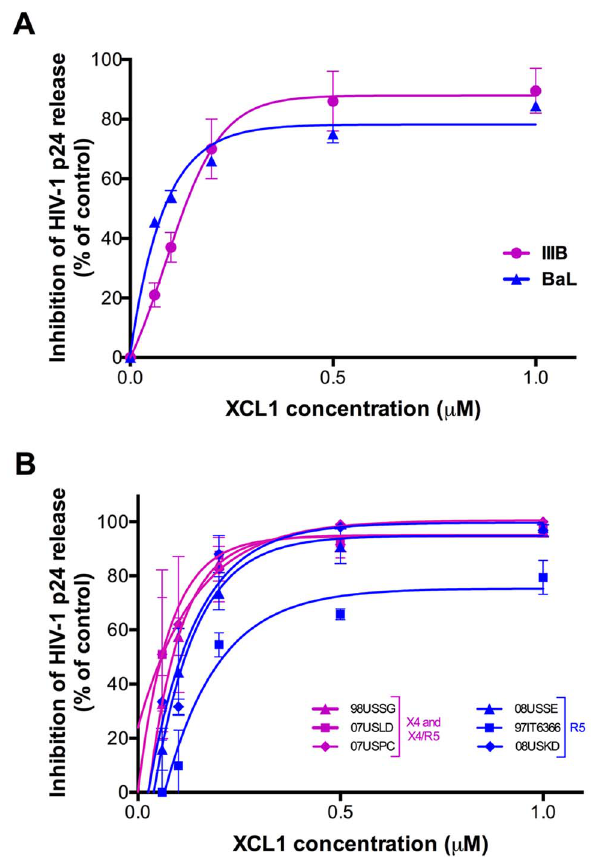
Figure 2. XCL1 inhibits HIV-1 infection irrespective of core- ceptor usage. (A) Dose-dependent inhibition of prototypic X4 (magenta) and R5 (blue) HIV-1 strains (IIIB and BaL) by recombinant XCL1 (Peprotech) in PBMC. Virus replication was assessed by measuring the amount of p24 Gag antigen in culture supernatants via AlphaLISA immunoassay. Data were normalized to the amount of viral replication observed in control cultures (not treated with XCL1). Data represent the mean values ( 6 SD) of replicate wells, representative of at least 5 independent experiments performed on separate PBMC donors. (B) Similar infection protocols were performed on a larger panel of primary HIV-1 isolates with different coreceptor specificity. Inhibition curves in magenta represent CXCR4- and CXCR4/CCR5-tropic isolates, while those in blue represent CCR5-tropic viruses.